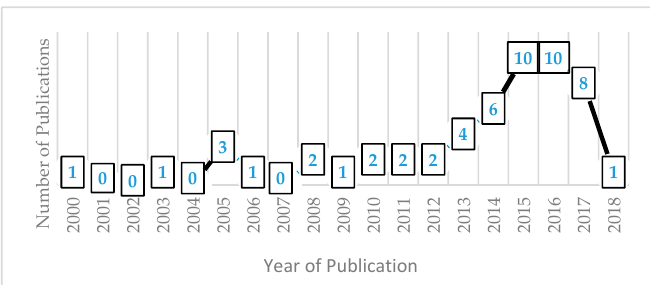
Figure 2. Number of annual publications.